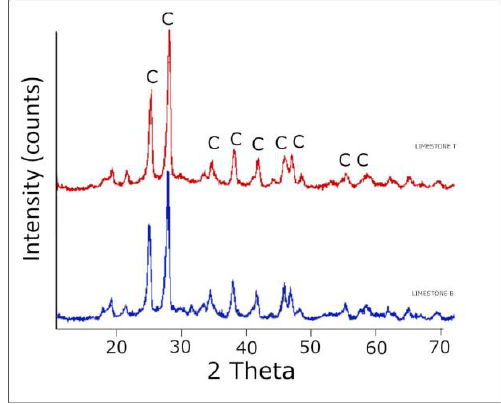
Figure 4. XRD tests of the limestones — limestone T (red line) and B (blue line). Limestone T and B come from different quarries and different geological formations.